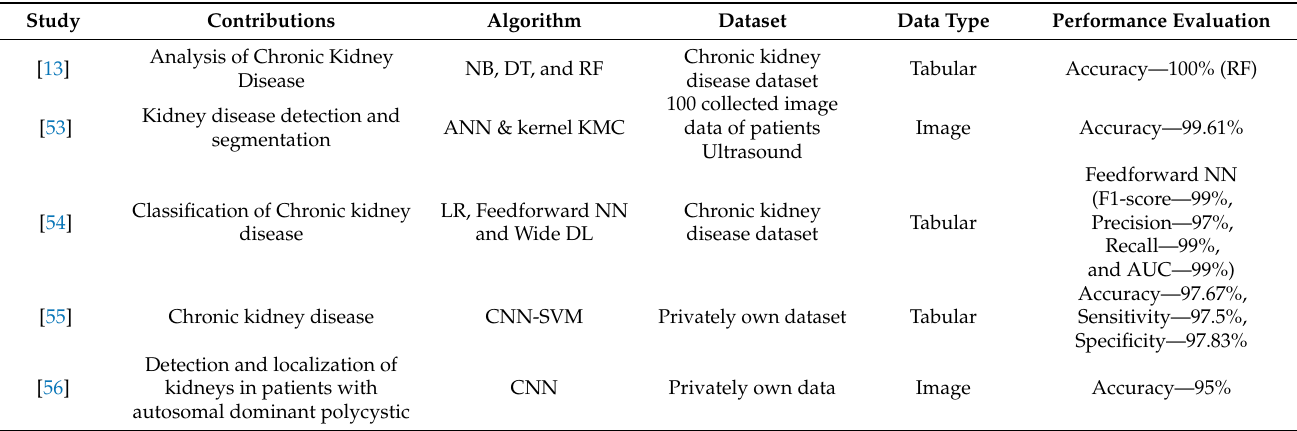
Table 4. Referenced literature that considered machine-learning-based kidney disease